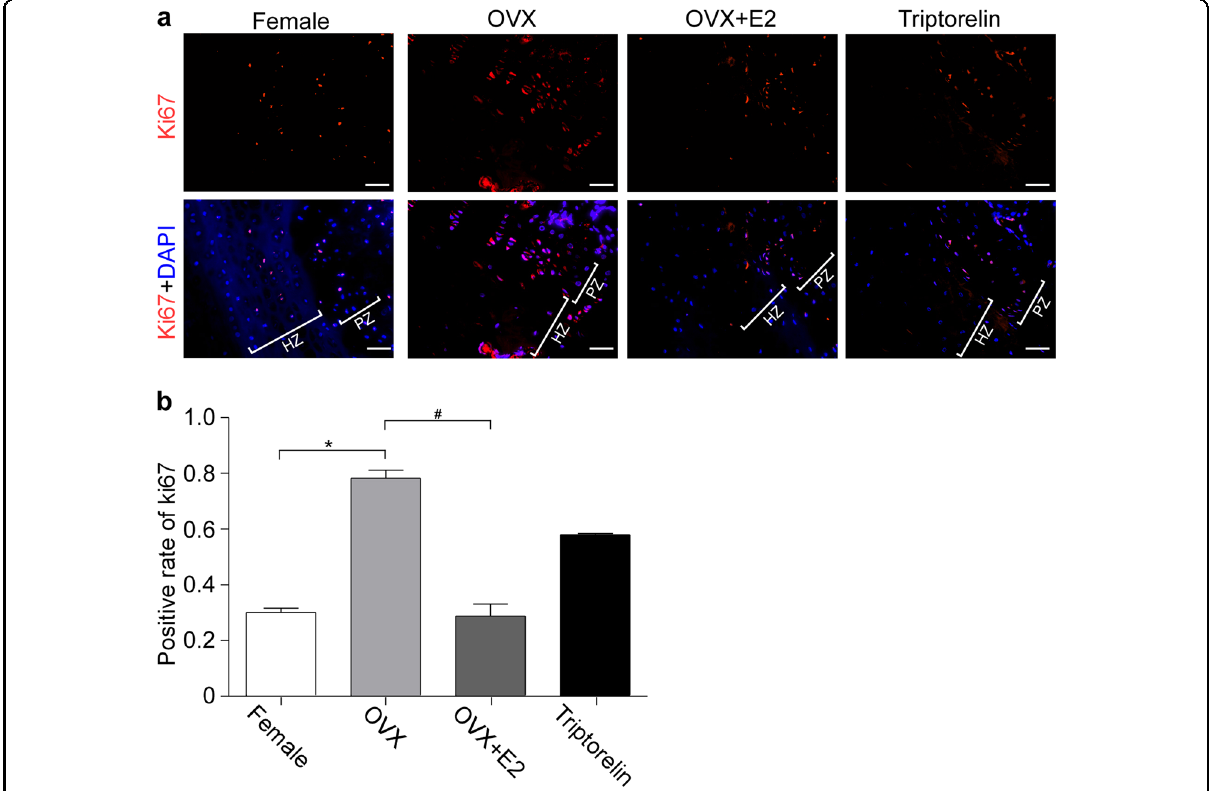
Fig. 5 Proliferation of the vertebral growth plate chondrocytes. a An anti-Ki67 antibody was used to label proliferating chondrocytes (red fl uorescence) and DAPI was used to label the nuclei (blue fl uorescence) of the vertebral growth plate chondrocytes. All experiments were repeated three times with consistent results, and representative images are shown. b Positive rate of Ki67-labeled nuclei in the images shown in ( a ) was quanti fi ed. Scale bars, 25 μ m. In ( b ), *means P < 0.05 compared with the female group, by the chi-square test ( χ 2 test). HZ represents the hypertrophic zone, and PZ represents the proliferative